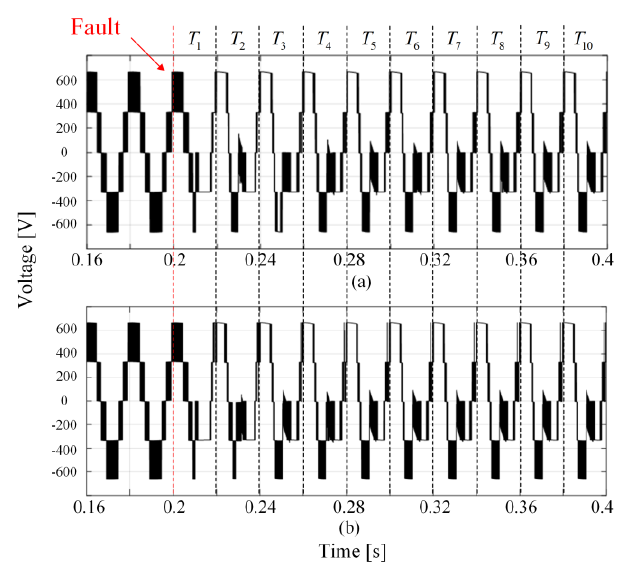
S and S open-circuit faults at 2 3